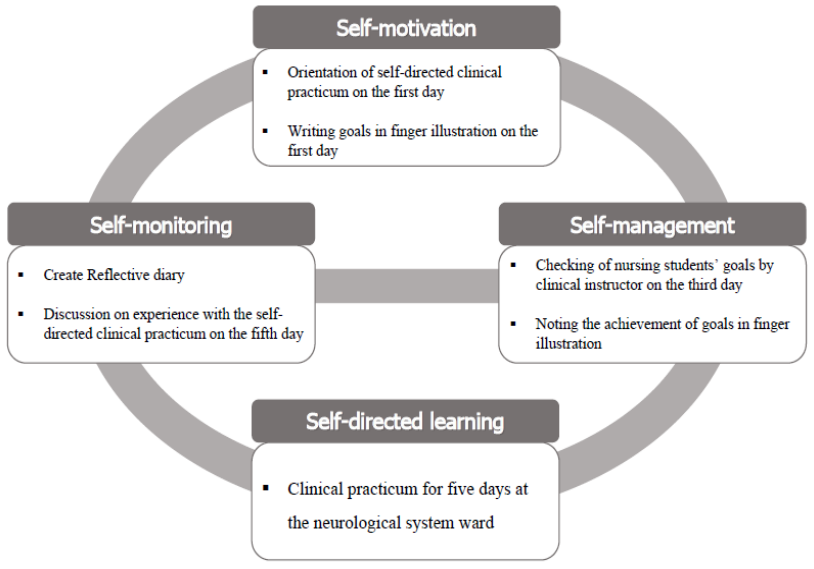
Figure 1. Conceptual framework.